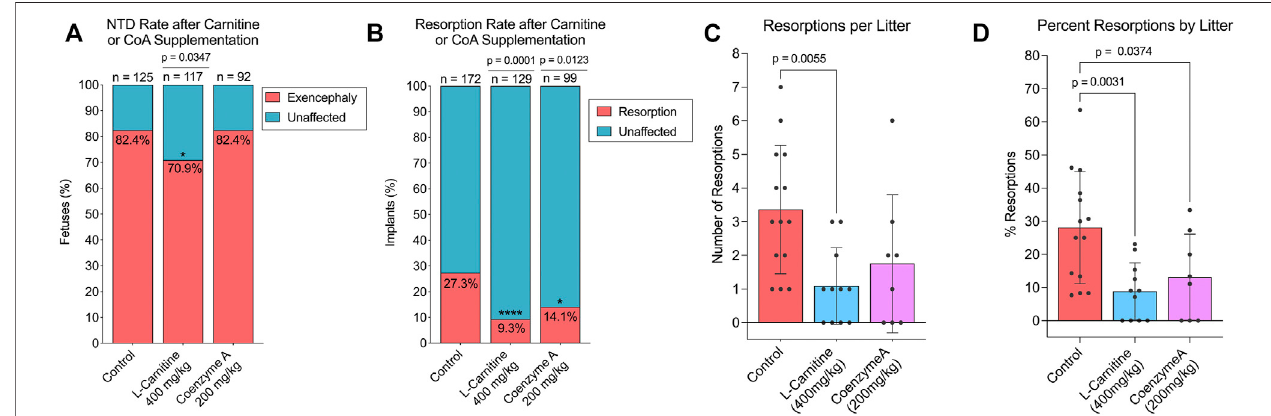
FIGURE 4 | Effect of L-carnitine or coenzyme A supplementation on NTD and resorption rates in VPA-treated SWV. (A) Proportion of embryos with exencephaly phenotypes observed in the placebo, L-carnitine (400 mg/kg), and coenzyme A (200 mg/kg) groups. (B) Proportion of resorption phenotypes observed in the placebo,